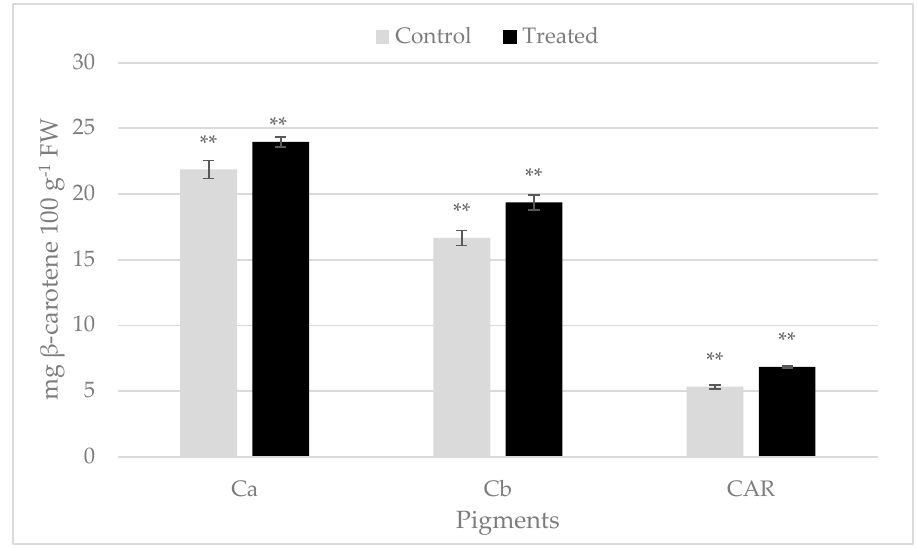
Figure 1. Photosynthetic pigments in the rocket leaves treated with Bortan (Treated) and in the untreated samples (Control) (Ca: chlorophyll a; Cb: chlorophyll b; CAR: total carotenoids). The grey bars indicate the control samples and black bars the treated ones. Pigment content is expressed as mg β -carotene 100 g − 1 FW; ** significant for p ≤ 0.01.